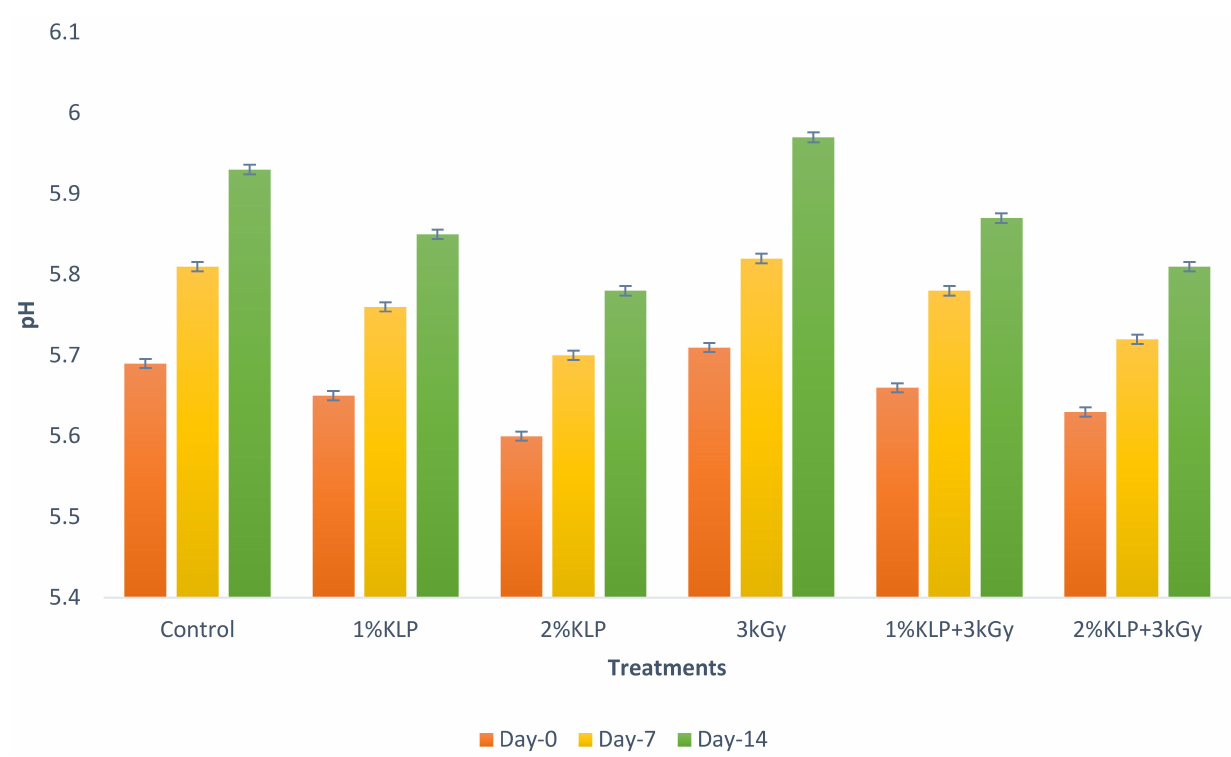
Figure 1. pH value of chicken meat treated with kale leaf powder and gamma irradiation at different storage